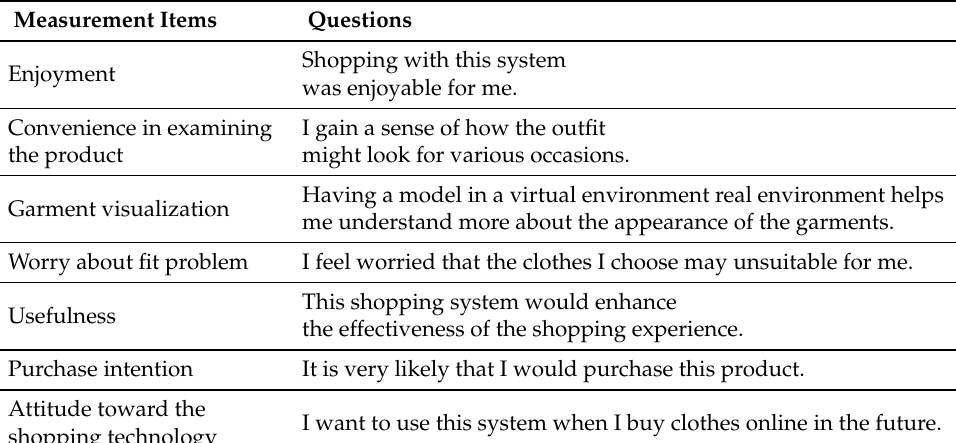
Table 1. Questionnaire and measurement